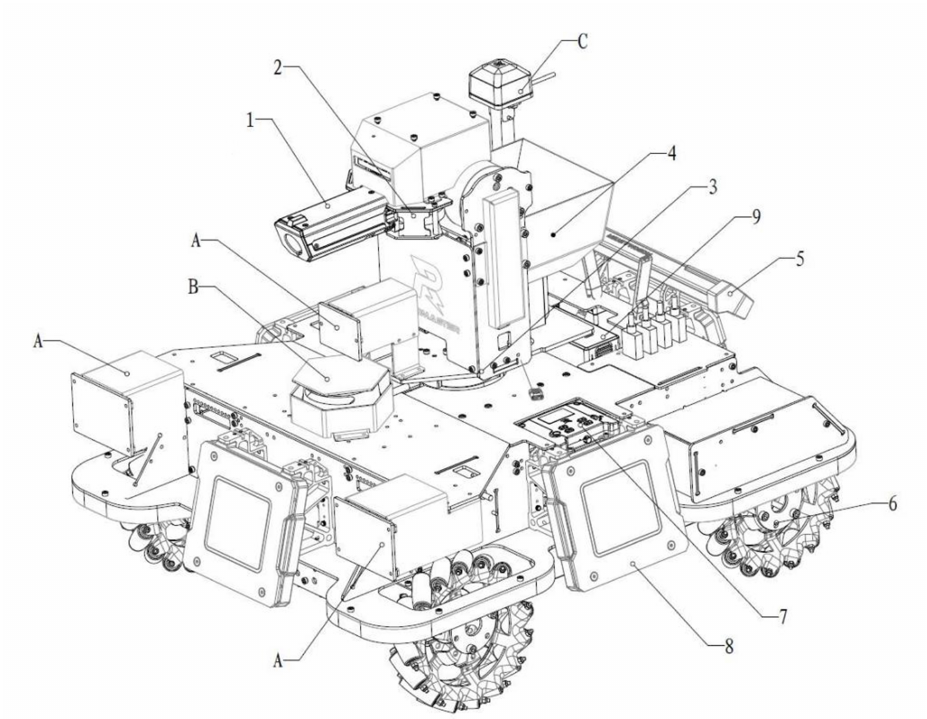
Figure 1. Robot platform. The characters and numbers in the diagram represent equipment modules, the details of which are shown below: 1. Referee system speed measurement module SM01. 2.